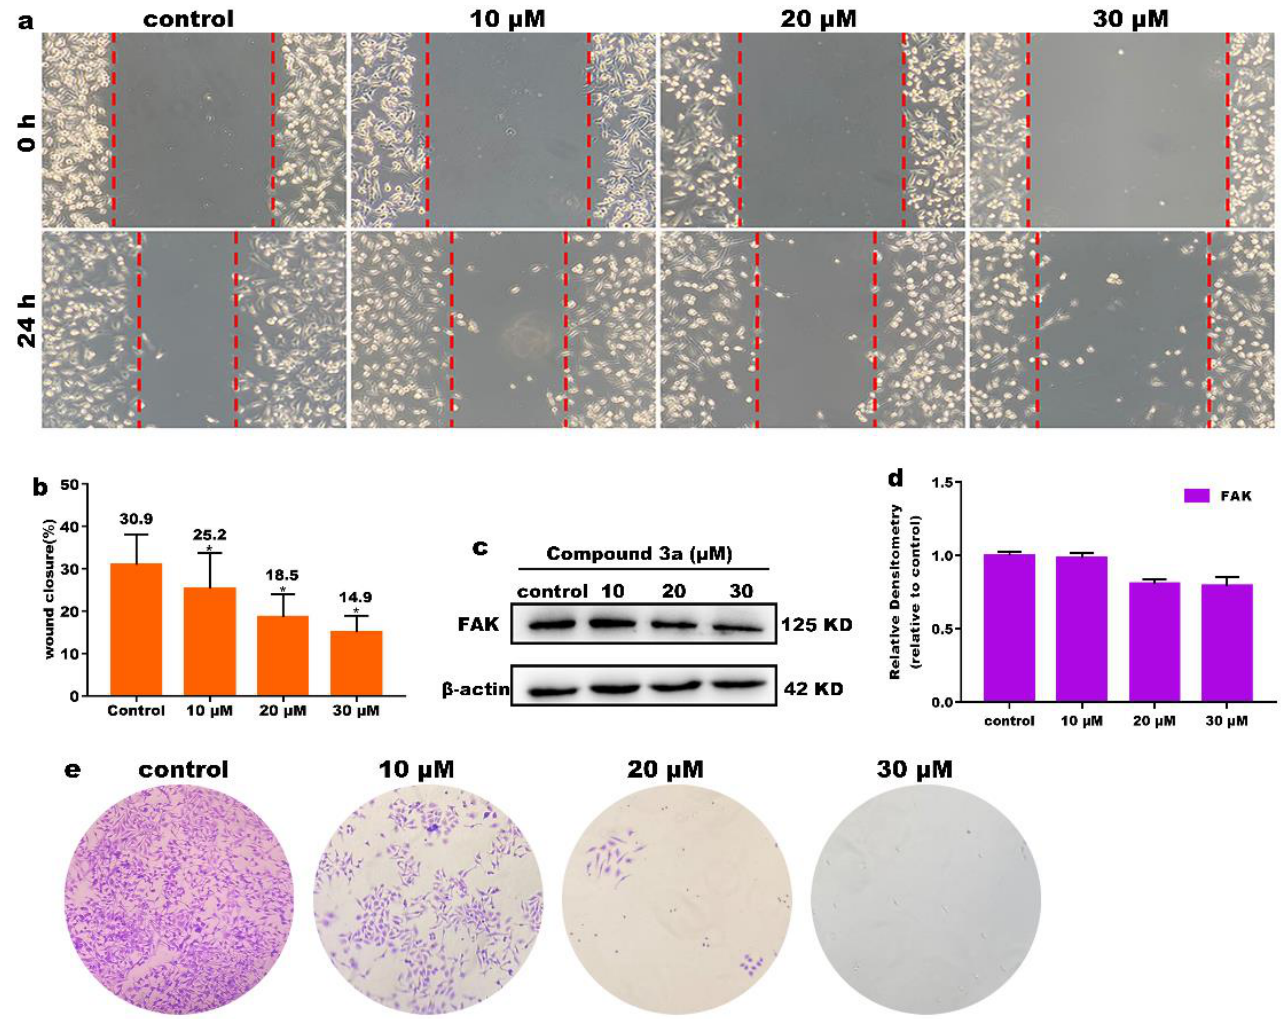
Figure 3. ( a ) The wound healing assay after HeLa cells were treated with different concentrations of compound 3a for 24 h. ( b ) Wound closure ratio values. ( c ) The expression of FAK and β-actin was used as the internal control. ( d ) Quantitative analysis of FAK protein expression. ( e ) Cell colonies of HeLa treated with compound 3a for continuous 10 days.